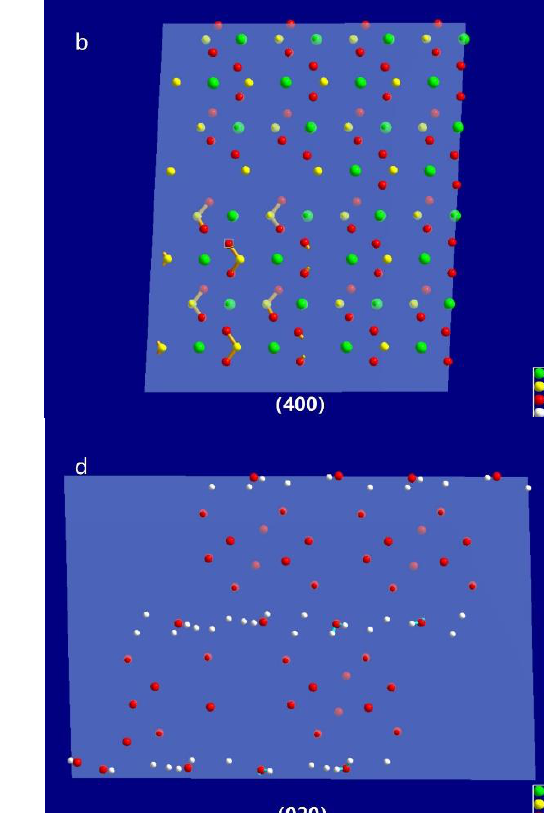
Figure 10. XRD pattern of the samples with columnar shape.